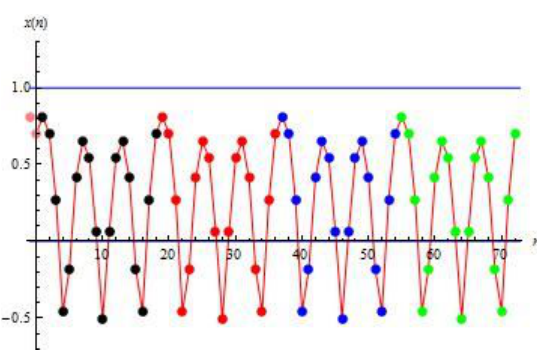
Figure 13. Period 18 for α = 0.5 t( − 1) = 0.812543579771728‘, t(0) = 0.6983061967141229‘ (see Table